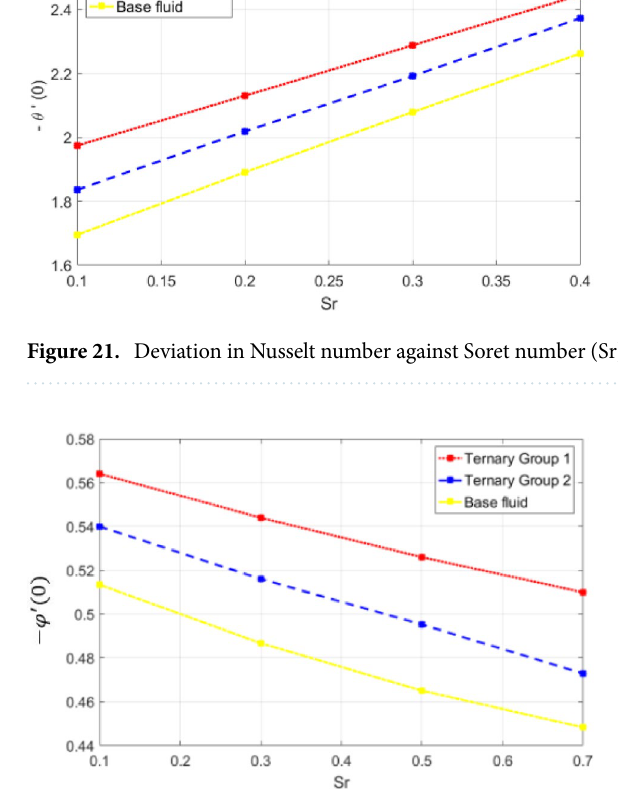
Figure 22. Deviation in Sherwood number against Sr number (Sr).